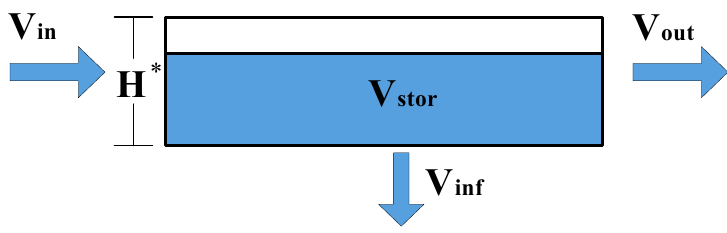
Figure 1. Schematic diagram of water balance for LID device ( H * is the designed depth).